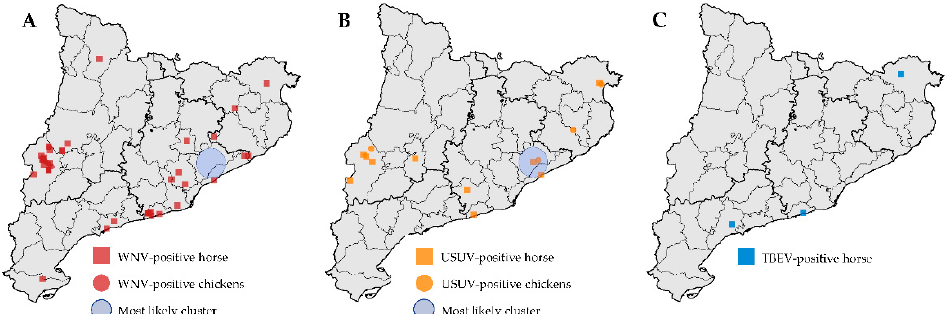
Figure 2. Distribution of WNV-positive samples ( A ) and USUV-positive samples ( B ) used for the purely spatial Bernoulli model implemented in SaTScan for WNV and USUV, which included horses and chickens. Distribution of TBEV-positive samples in horses ( C ).